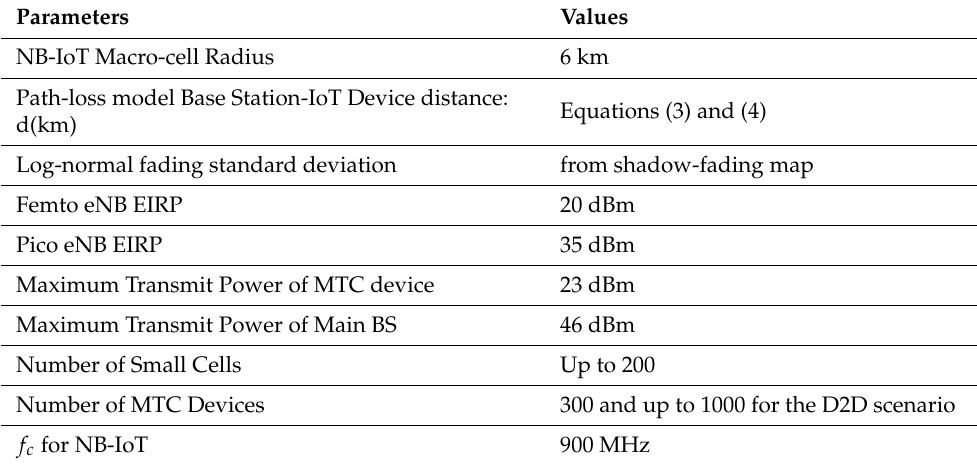
Table 2. Simulation Key parameters.